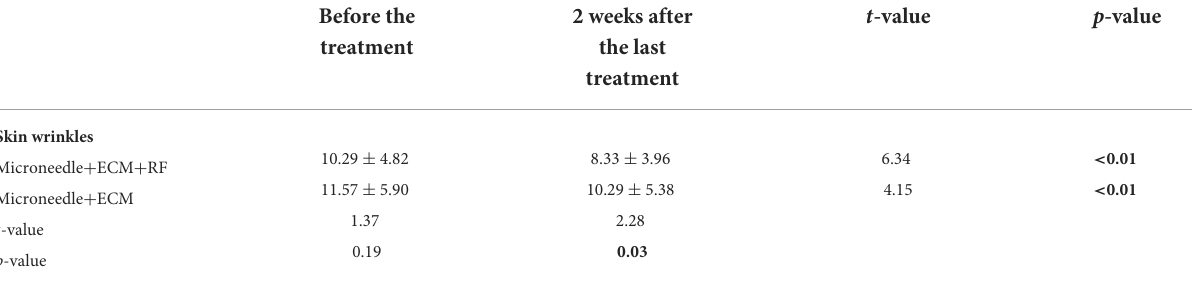
TABLE 2 Comparison of the results of periorbital wrinkles as measured by the VISIA system.